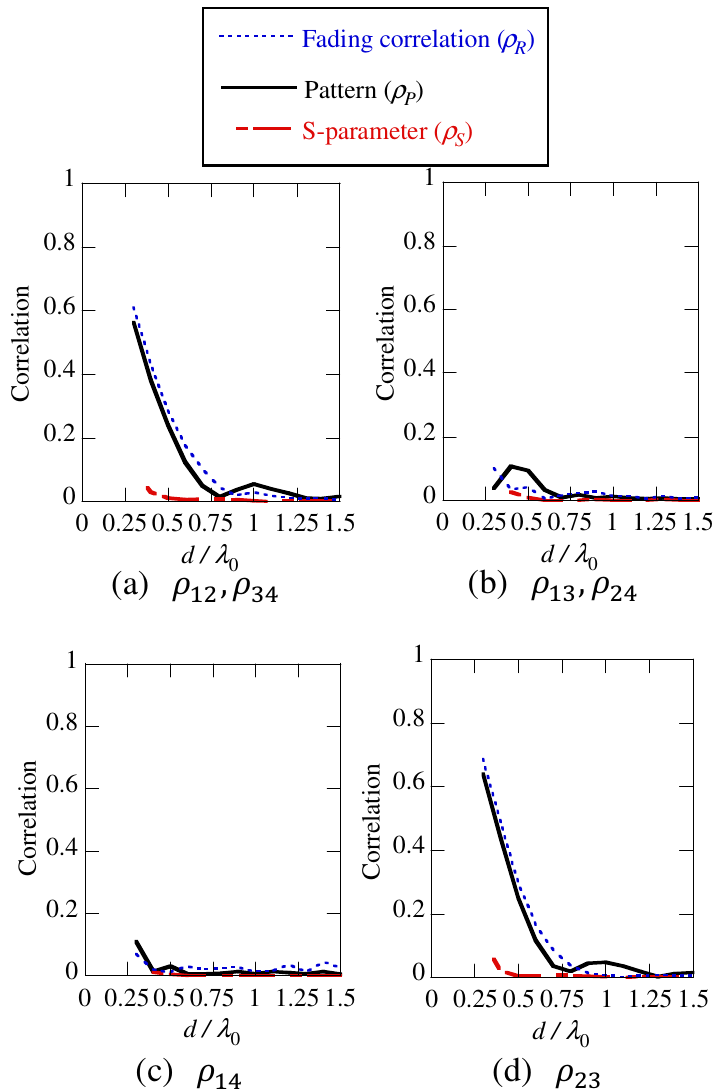
Figure 12. Correlation coefficient versus element spacing d : MSAA ( M =